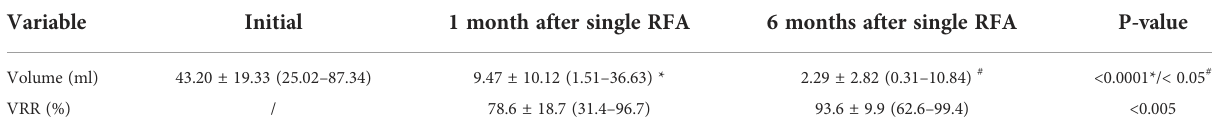
TABLE 3 The ef fi cacy of singe RFA treatment.